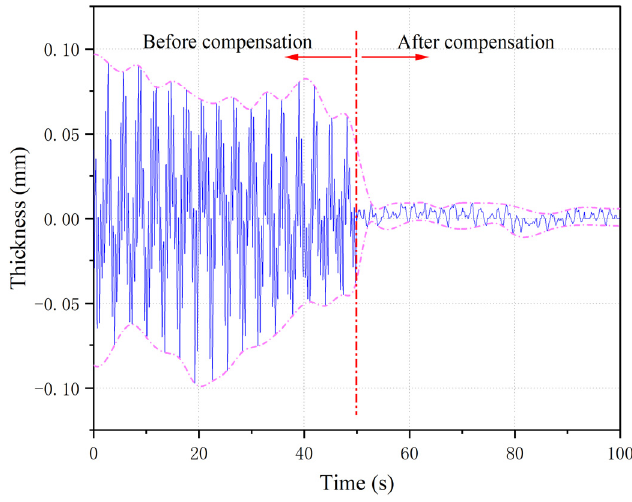
Figure 15. The control effect of eccentricity compensation.